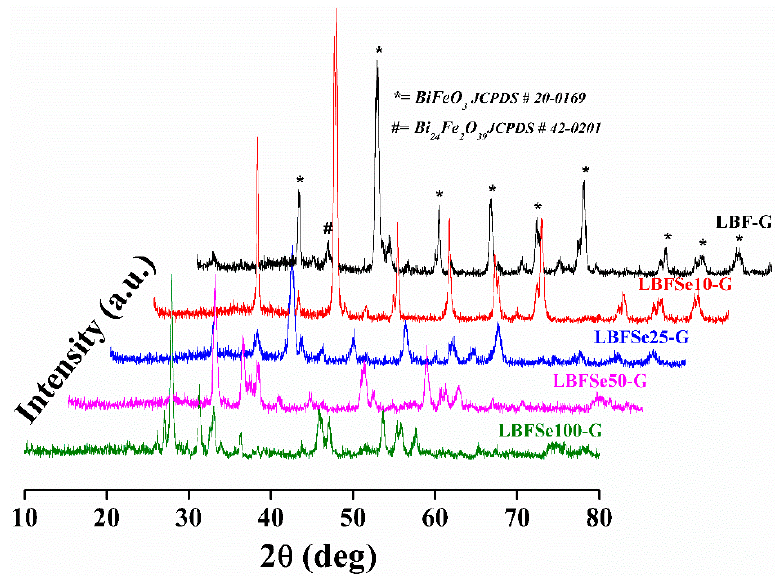
Figure 1. The XRD pattern of La 3+ and Se +4 co-doped BiFeO 3 (BFO) nanohybrids with graphene oxide samples.